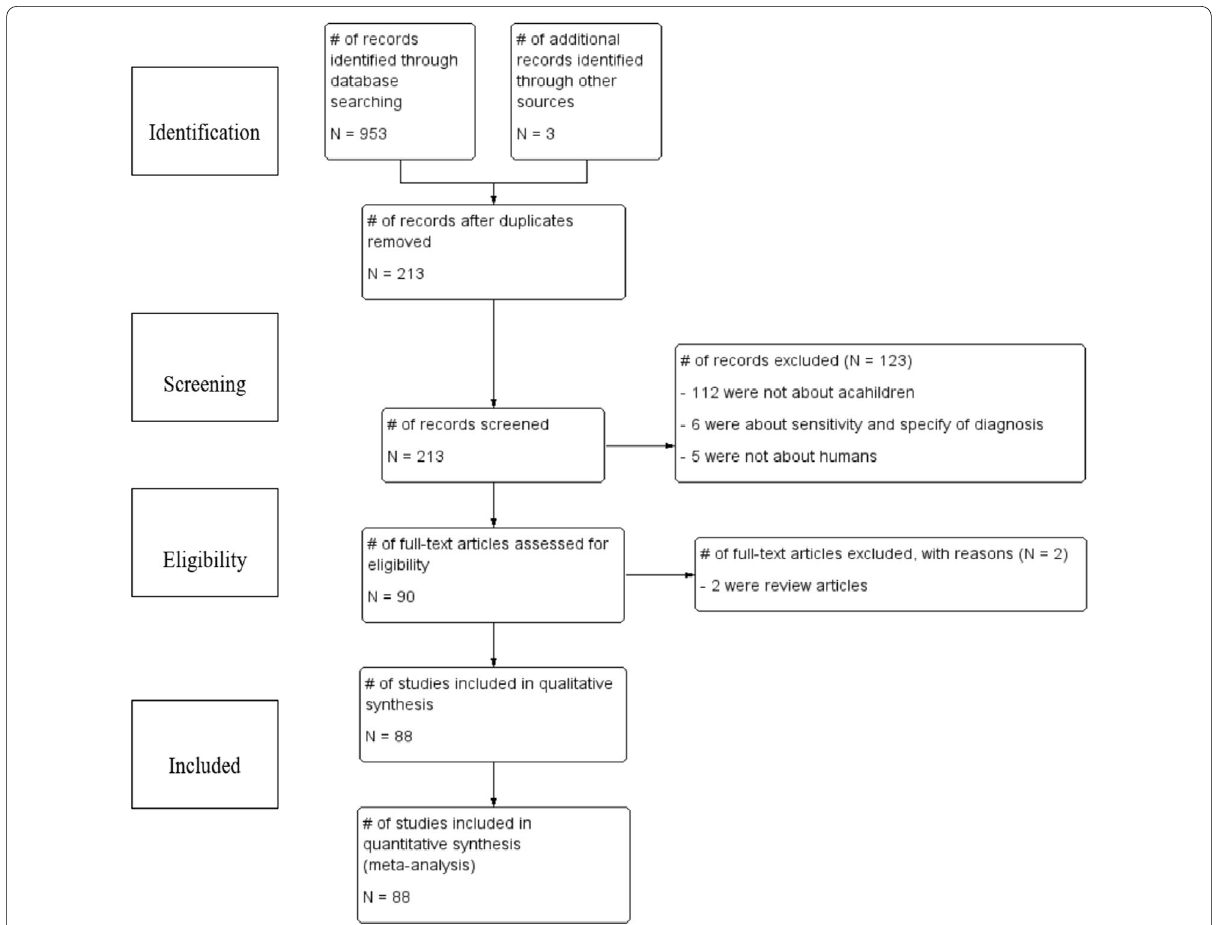
Fig. 1 Flow diagram showing the selection